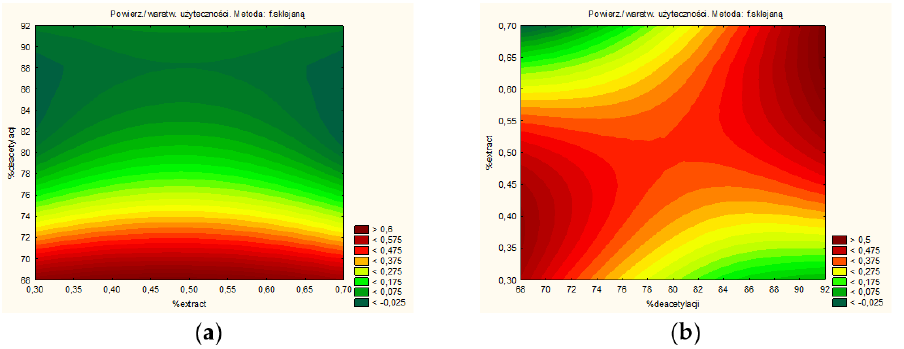
Figure 9. Model utility contour profiles for chitosan systems for effect with a negative sign ( a ) antioxidant and anti-hyaluronidase activities, and positive sign ( b ) release of baicalin and component of Powierz./warstw. użyteczności. Metoda: f.sklejaną Powierz./warstw. użyteczności. Metoda: f.sklejaną